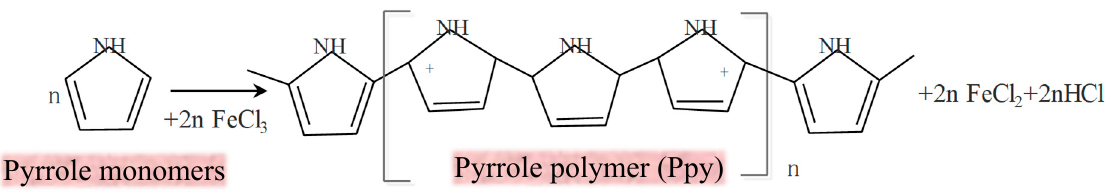
Figure 1. Formation scheme of Ppy with pyrrole monomers.